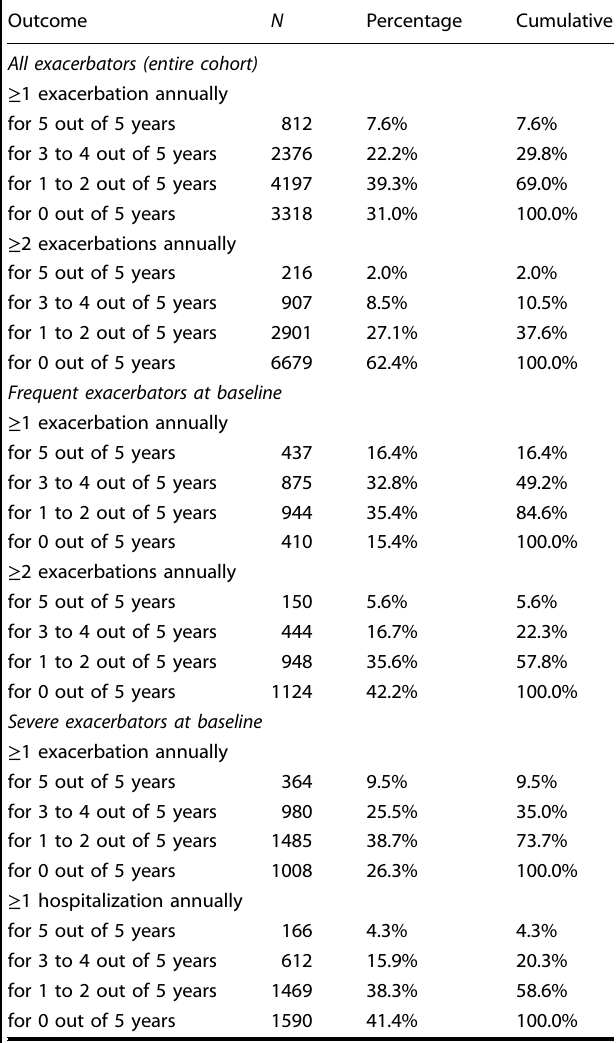
Table 3. Stability at an individual